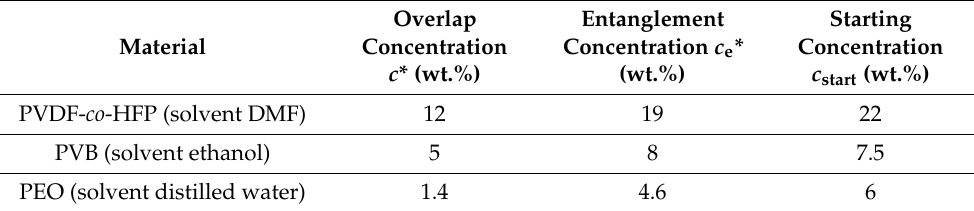
Table 2. Summary of the individual concentrations for all three used polymeric materials. Material